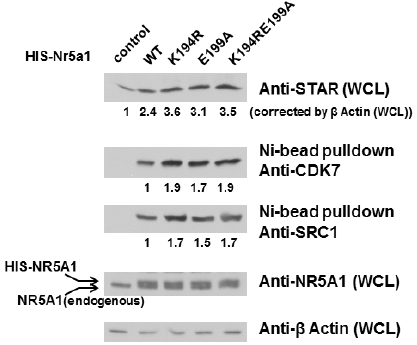
protein level. Mouse adrenocortical cancer Y1 cells were transfected with WT, K194R, E199A, or K194RE199A Nr5a1 expression plasmid (1 µg). After 48 h, whole cell